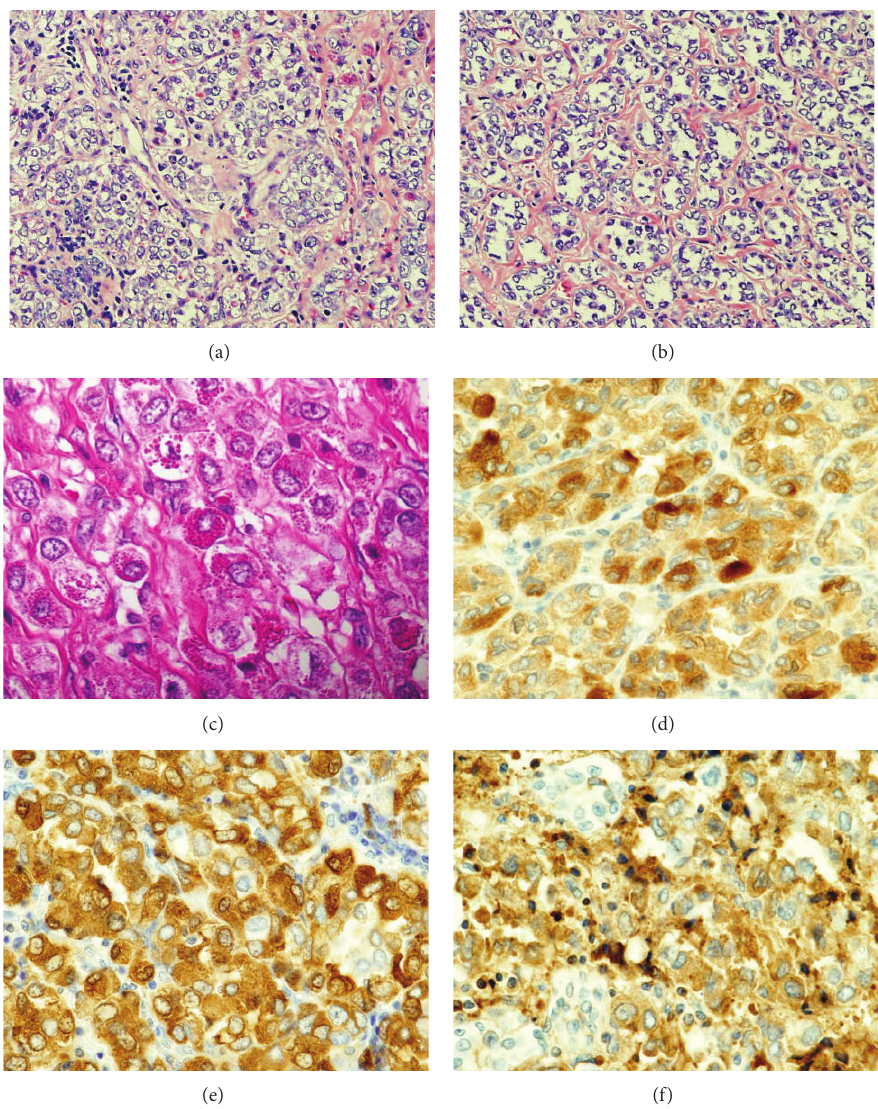
Figure 4: Microscopic findings showed that the tumor had an infiltrative growth pattern with a combination of solid (a), trabecular, and microglandular (b) features. Many of the tumor cells had clear cytoplasm containing large, coarse, and bright red granules which resemble acinar cells of the salivary glands (c). Immunohistochemical staining showed that most of the tumor cells stained strongly for amylase (d), lysozyme (e), and 𝛼 1ACT